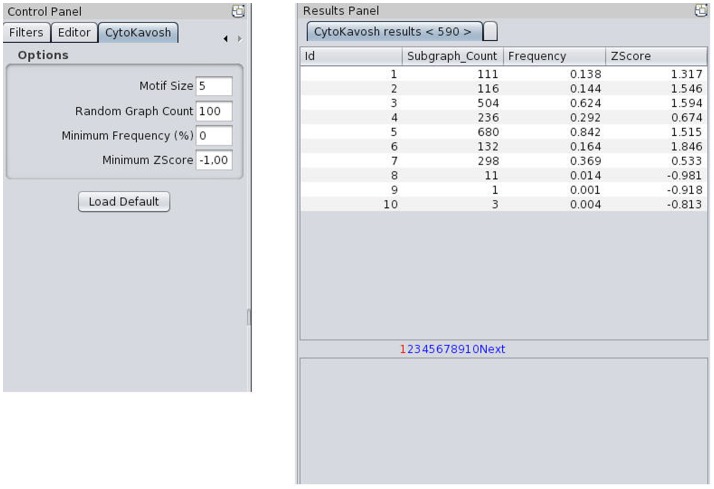
Control Panel of CytoKavosh, including the CytoKavosh control tab for getting input parameters.The right side of the figure shows the ‘results’ table panel after running the CytoKavosh for given input parameters. A table for each run of plug-in appears in the separate tab in ‘result’ panel. These tabs keep the results until finishing the plug-in. For larger sizes of the motifs, the number of detected motifs increases exponentially. So, the ‘results’ table can be explored page by page. The below panel shows the graphical representation of selected motif in the table.